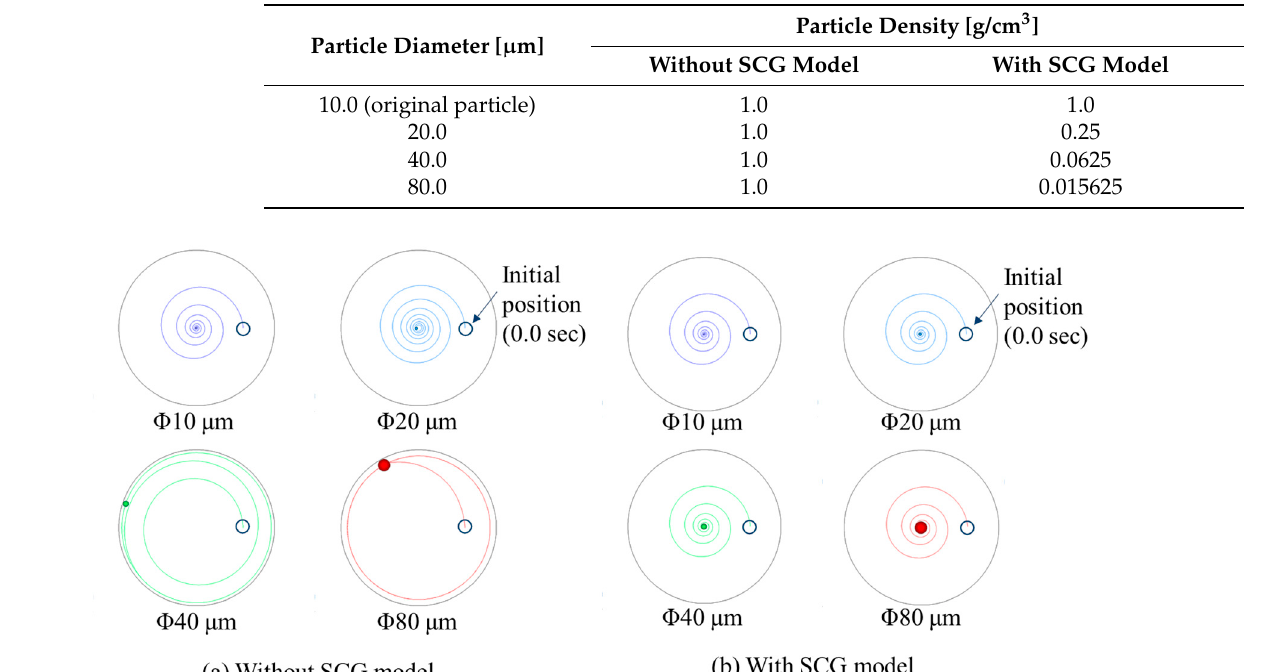
Table 2. Simulation conditions (vortex flow field).